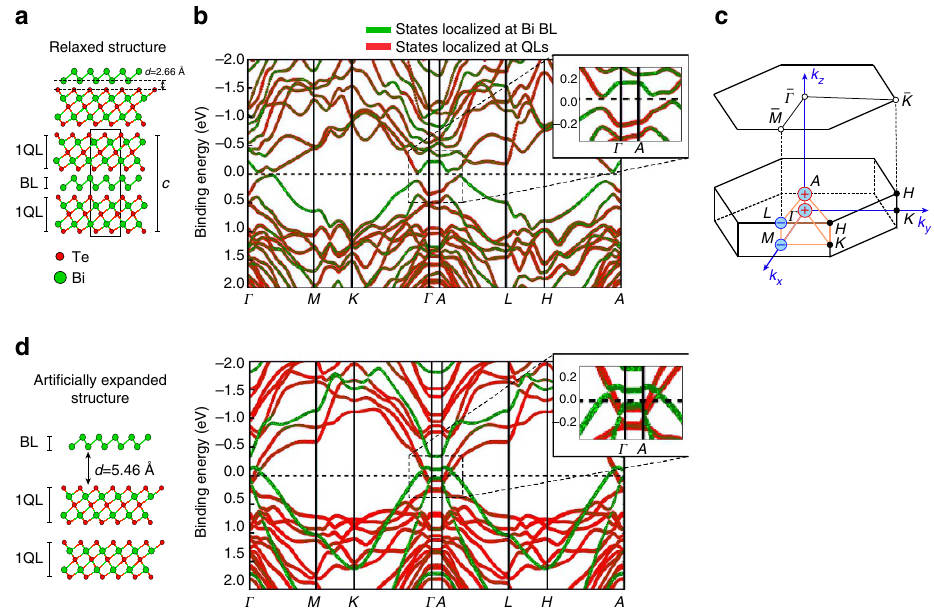
Figure 1 | Bulk band structures of Bi 1 Te 1 . ( a ) Simple sketch of the crystal structure of Bi 1 Te 1 . The unit cell consists of 1Bi BL and 2QLs. ( b , d ) The bulk band structure calculation in the structurally relaxed geometry ( c ) and with artificially expanded distances between the BL and the QLs ( d ), respectively. States localized mostly in the BL are marked in green, while the states localized mostly in the 2QLs are shown in red. In d , the band structure of the BL shows an inverted gap about 0.2eV above the Fermi level ( E F marked with a dashed line). ( c ) Bulk and surface Brillouin zone with parity product of the TRIM points for the relaxed structure resulting in þ 1 (red ‘ þ ’) or (cid:2) 1 (blue ‘ (cid:2) ’). The k z direction corresponds to the stacking direction. G AML , that is, ( k x , k z )-plane, marks a mirror